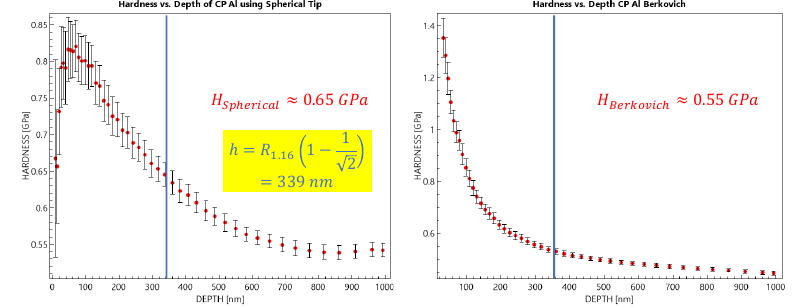
Figure 36. Comparison of hardness measured using 1.16 µ m radius spherical tip as well as Berkovich indenter tip for commercially pure aluminum. The slight di ff erence in hardness is expected, given the fact that “hardness’s measured with a spherical indenter are not necessarily the same as those for the Berkovich”, as established by Oliver and Pharr